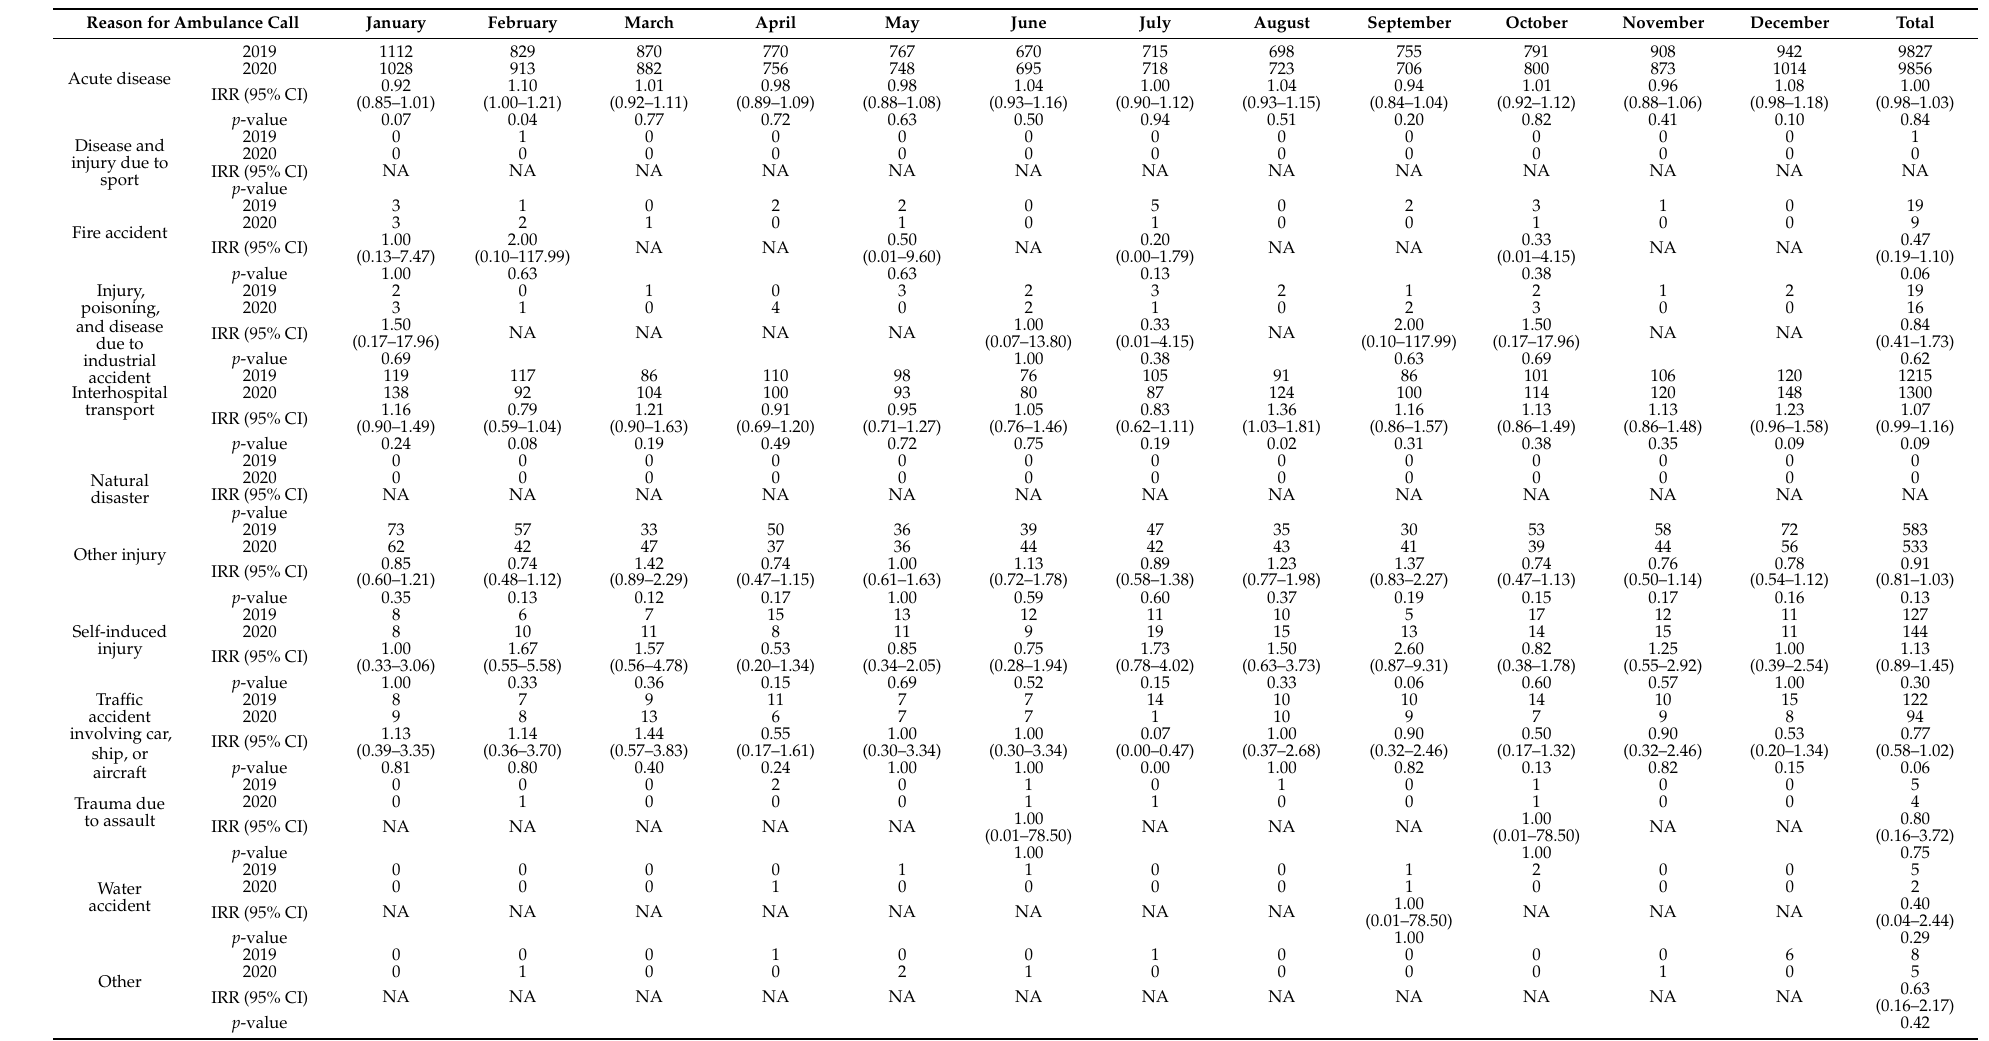
Table 3. The number of deaths among hospitalized emergency patients registered in the Osaka Emergency Information Research Intelligent Operation Network system. Reason for Ambulance Call Acute disease Disease and injury due to sport Fire accident